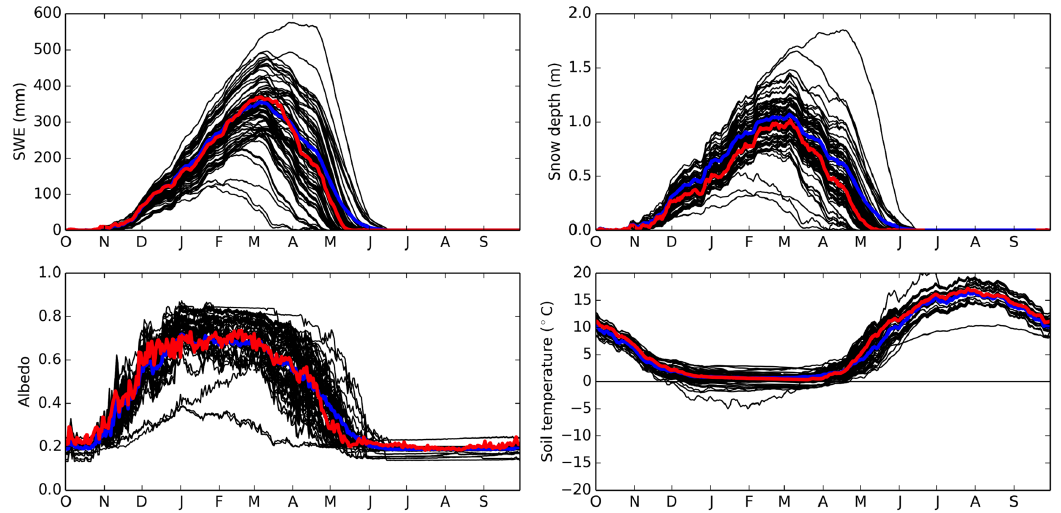
Figure 2. Measurements (red lines), simulations (black lines), and averages of simulations (blue lines) of SWE, snow depth, albedo, and soil temperature at 20cm of depth for Col de Porte averaged over October 1994 to September